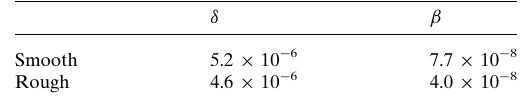
Table 2 Fitting parameters to index of refraction for smooth and rough samples.